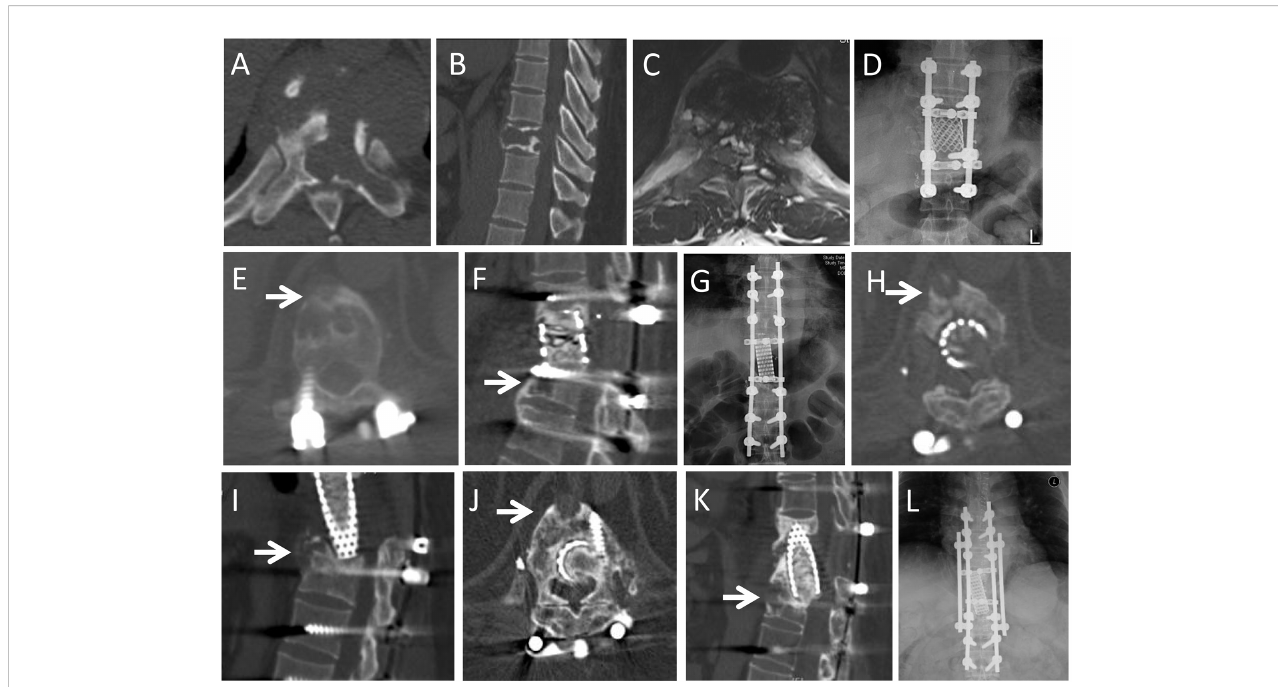
FIGURE 2 A 46-year-old male patient presented with back pain for one month. CT and MRI showed an osteolytic lesion in the T9 vertebra. He underwent GTR (en bloc vertebrectomy of T9). At 37-month follow-up, he complained of back pain for 3 months, and CT and MRI demonstrated local recurrence at T10 vertebral body (arrows in E,F). He underwent GTR (en bloc vertebrectomy of T10). At 19 months after second operation, he had a sudden back pain and X-ray showed that rod fracture. He underwent the third operation to replace the broken titanium rod with cobalt-chromium-molybdenum rod. At 8 months after third operation, the CT and MRI revealed the local recurrence at anterior part of T11 vertebral body (arrows in H,I). He underwent radiotherapy but refused further surgery. The recurrent lesion was stable in subsequent 52 months follow-up (arrows in J,K), but the rob fractured again. He had to underwent forth operation to replace the rod. (A,B) : Preoperative axial and sagittal CT scans revealed the osteolytic lesion extended from the T9 vertebral body to the left pedicle and transverse process; (C) : T2-weighted axial MRI scans; (D) : Posteroanterior X-ray after fi rst operation; (E,F) : Axial and sagittal CT scans at 37-month follow-up after the fi rst operation; (G) : Posteroanterior X-ray after second operation; (H,I) : Axial and sagittal CT scans 8 month later after third operation; (J,K) : Axial and sagittal CT scans in 44th month after radiotherapy; (L) : Posteroanterior X-ray after fourth operation.